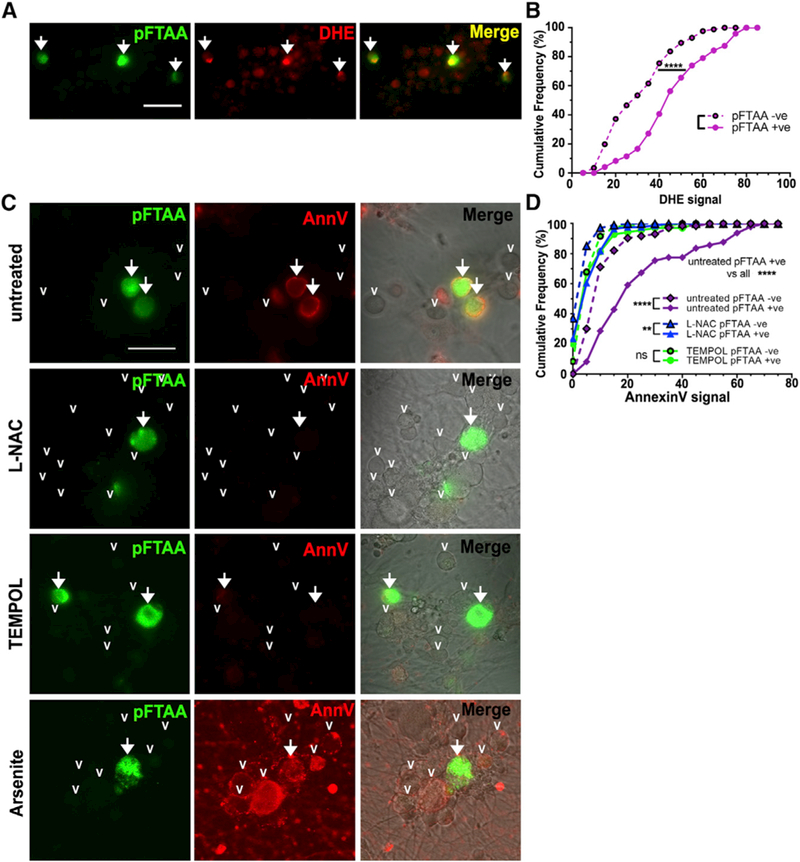
Tau Aggregates Cause PS Externalization through a ROS-Dependent Mechanism(A and B) Representative image (A) of DRG neurons from 5-month-old P301S mice showing higher intensity of nuclear oxidized
DHE staining (red) in pFTAA+ (arrows) versus pFTAA- neurons. Scale bar, 25 μm. (B) Cumulative
frequency plot quantifying DHE fluorescence intensities for pFTAA+ and pFTAA- DRG neurons; ≥30
neurons per one culture from n = 3 independent experiments. Kolmogorov-Smirnov test. ****p < 0.0001.(C) Loss of AnnV binding to pFTAA+ DRG neurons (arrows) from 5-month-old P301S mice treated with 5 mM NAC or 5
mM TEMPOL for 2 days before washing and staining live with AnnV-647. Arrowheads indicate pFTAA- neurons. Pro-oxidant
arsenite (0.5 mM, 15 min) causes intense AnnV- 647 staining in all neurons without any cell death (PI-). Scale bar, 30
μm.(D) Cumulative frequency plots quantifying AnnV- 647 fluorescence intensity values for pFTAA+ and
pFTAA- DRG neurons treated as in (C); >30 neurons from n = 3 independent experiments. Kolmogorov-Smirnov
test, Bonferroni corrected. Comparison of pFTAA+ values with all others, ****p < 0.0001. Values comparing
pFTAA+ versus pFTAA-: untreated, ****p < 0.0001; NAC, **p < 0.01; TEMPOL, n.s.